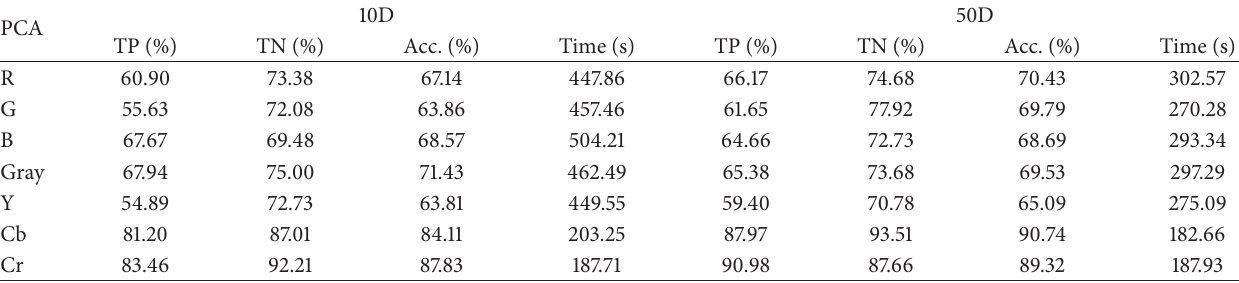
Table 2: Detection accuracy and computational time for RLRN with PCA in 10D and 50D.